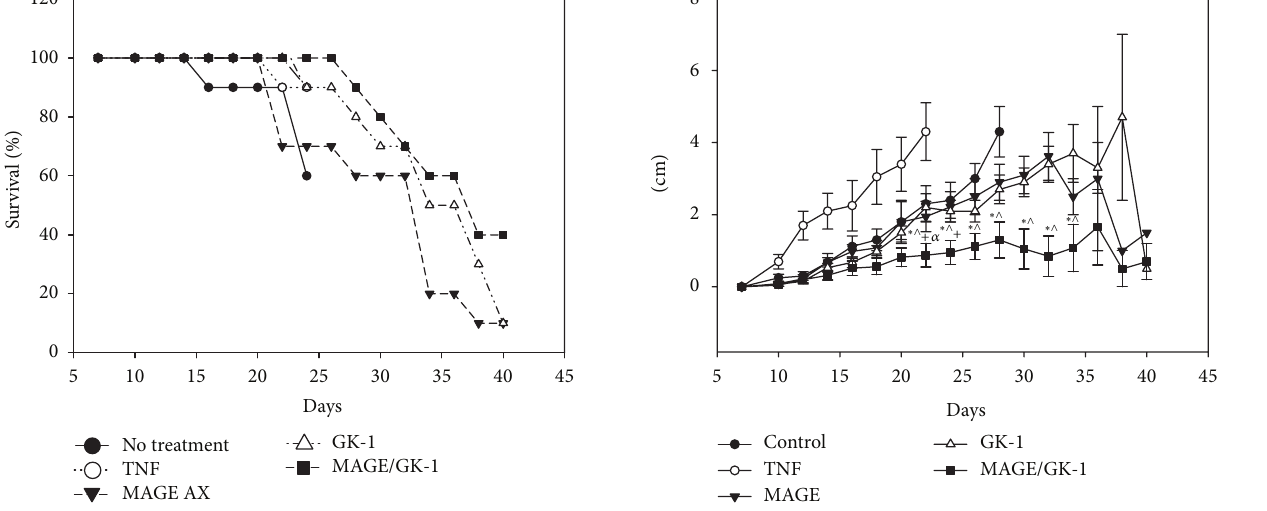
Figure 4: Tumor development. Tumor size in mice inoculated with BMDCs matured with TNF 𝛼 and treated with MAGE-AX, GK-1, or MAGE-AX/GK-1. From day 22 to day 24 the group treated with MAGE/GK-1 BMDCs had less tumor growth in comparison with all groups. From day 26 no tumor growth was shown in the TNF 𝛼 and untreated groups, because the survival rate was 0%. Tumor growth of the MAGE-AX and GK-1 groups was similar. Without treatment (WT). Mean ± SEM 𝑛 ≥ 3 . ∗ 𝑃 < 0.05 MAGE/GK-1 versus MAGE, ∧ 𝑃 < 0.05 MAGE/GK-1 versus GK-1, + 𝑃 < 0.001 MAGE/GK-1 versus TNF, 𝛼 𝑃 < 0.001 MAGE/GK-1 versus